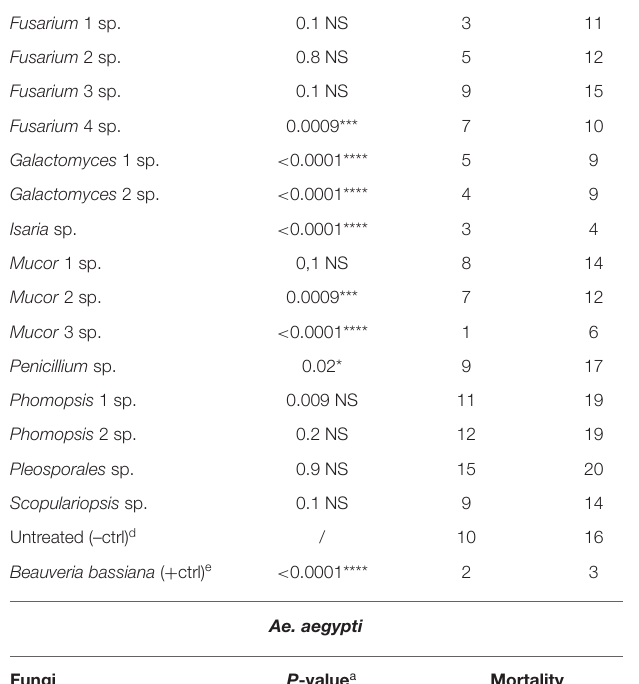
TABLE 2 | Mortality of An. gambiae and Ae. aegypti mosquitoes exposed through fungal direct-exposure assay. An. gambiae